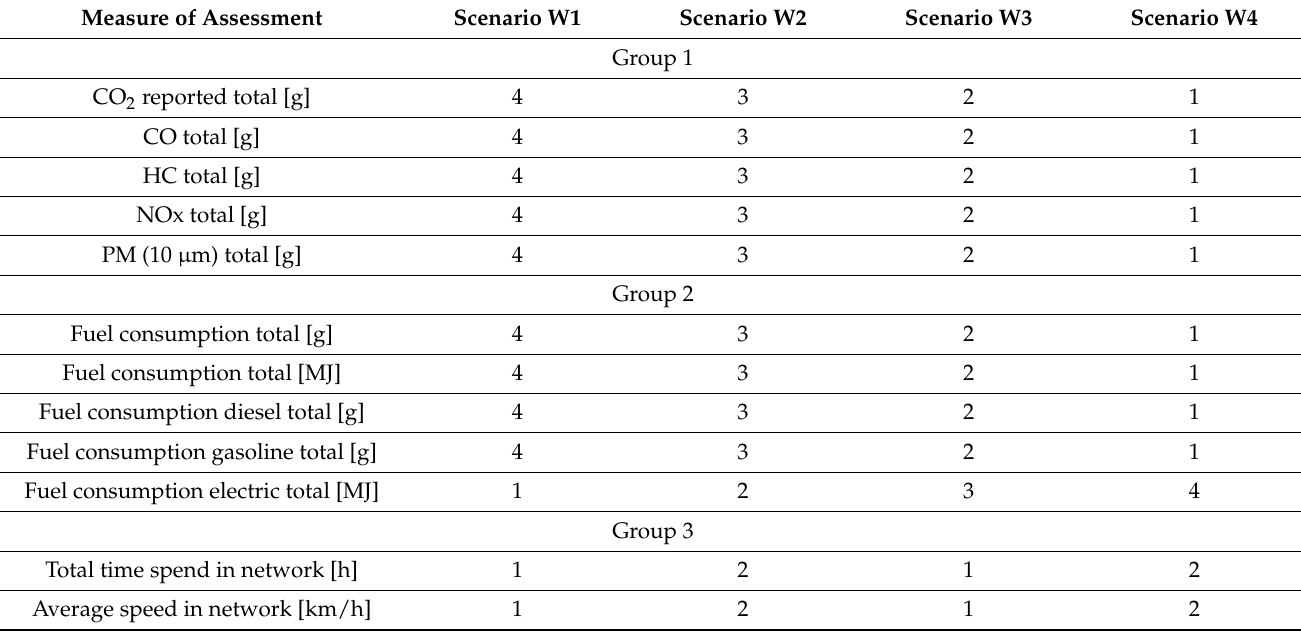
Table 6. Ranking of the scenarios—analysis for the whole city.